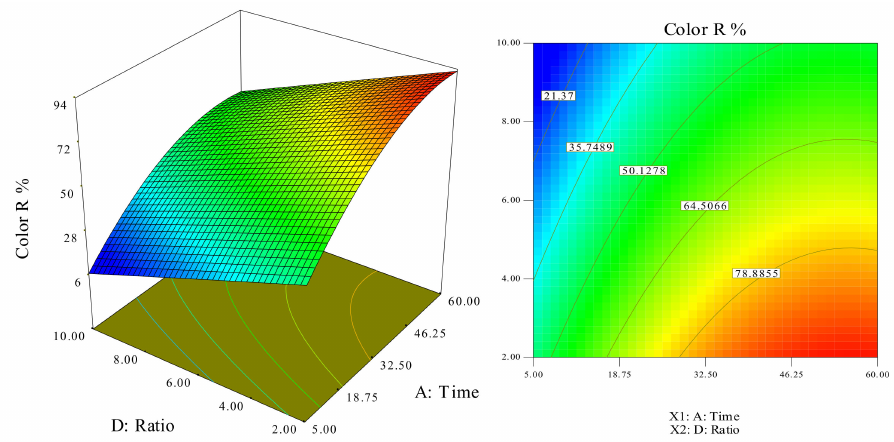
Figure 7. Role of reaction time and H 2 O 2 :Fe 2+ ratio in leachate decolorization depicted in 3D response surfaces and contour plot.